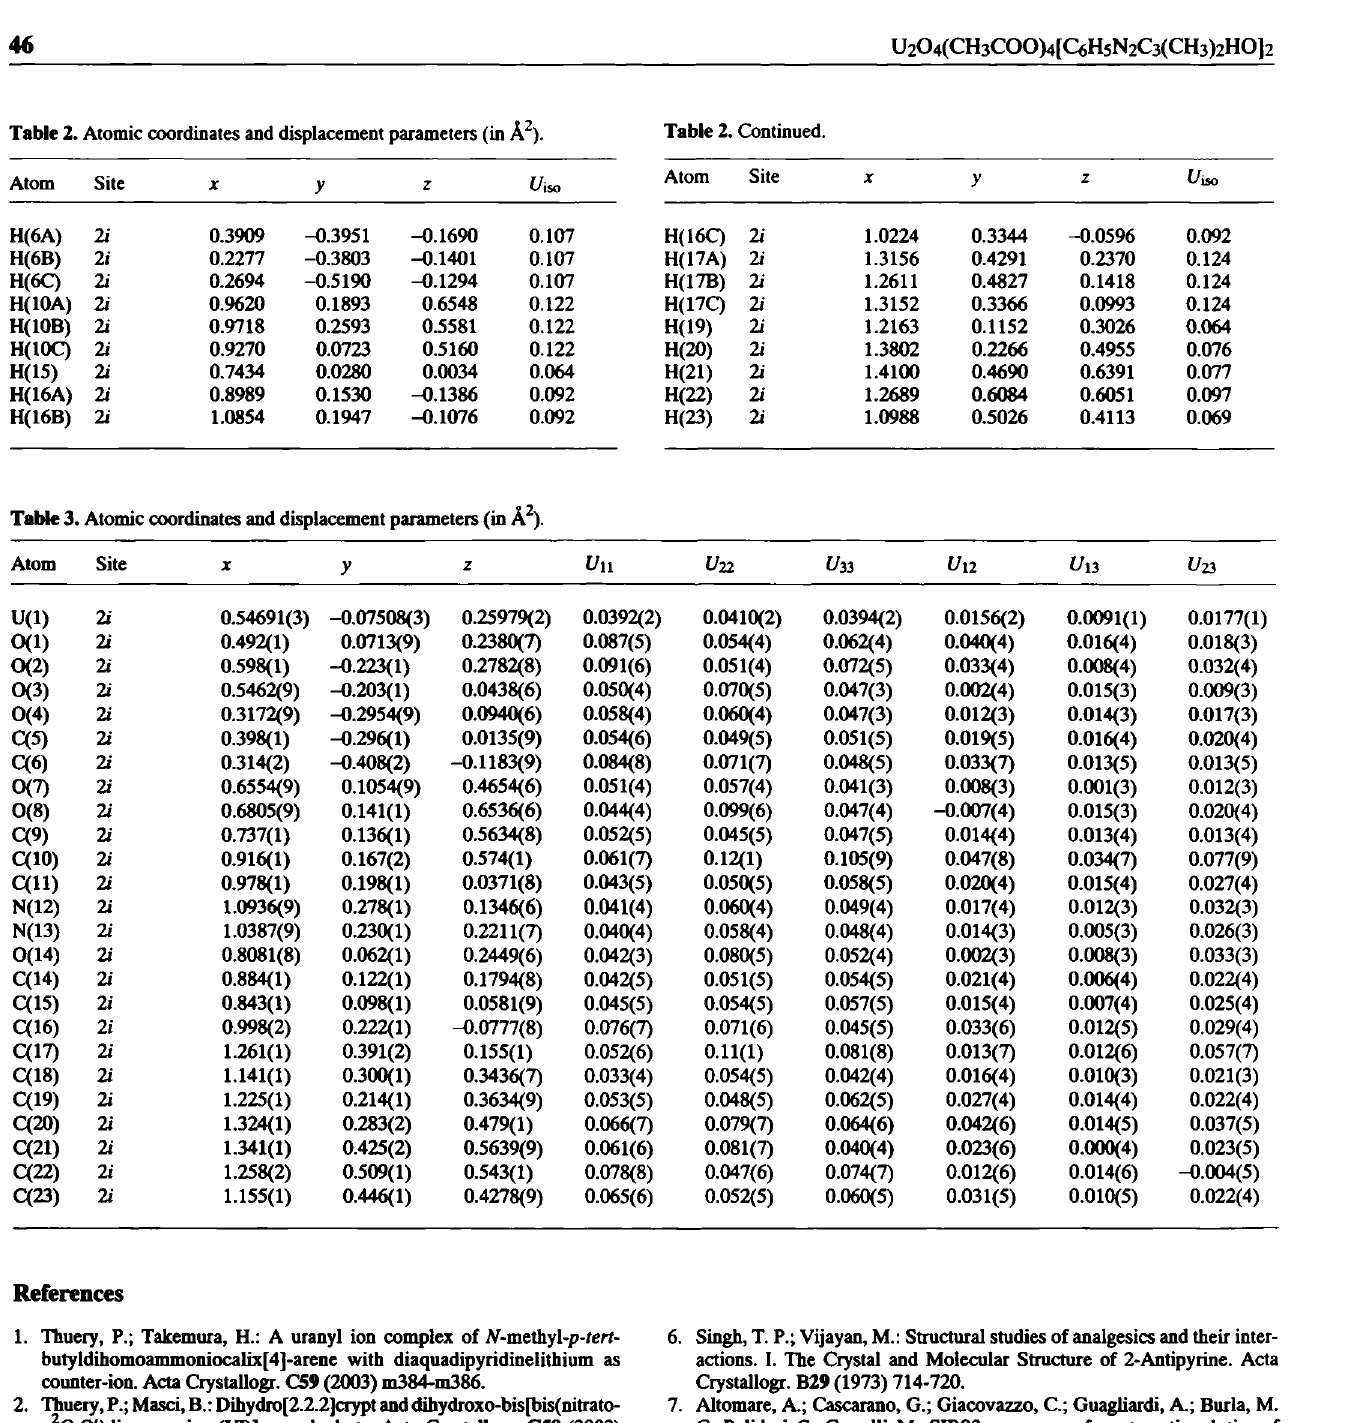
Table 2. Atomic coordinates and displacement parameters (in Ä 2 ).